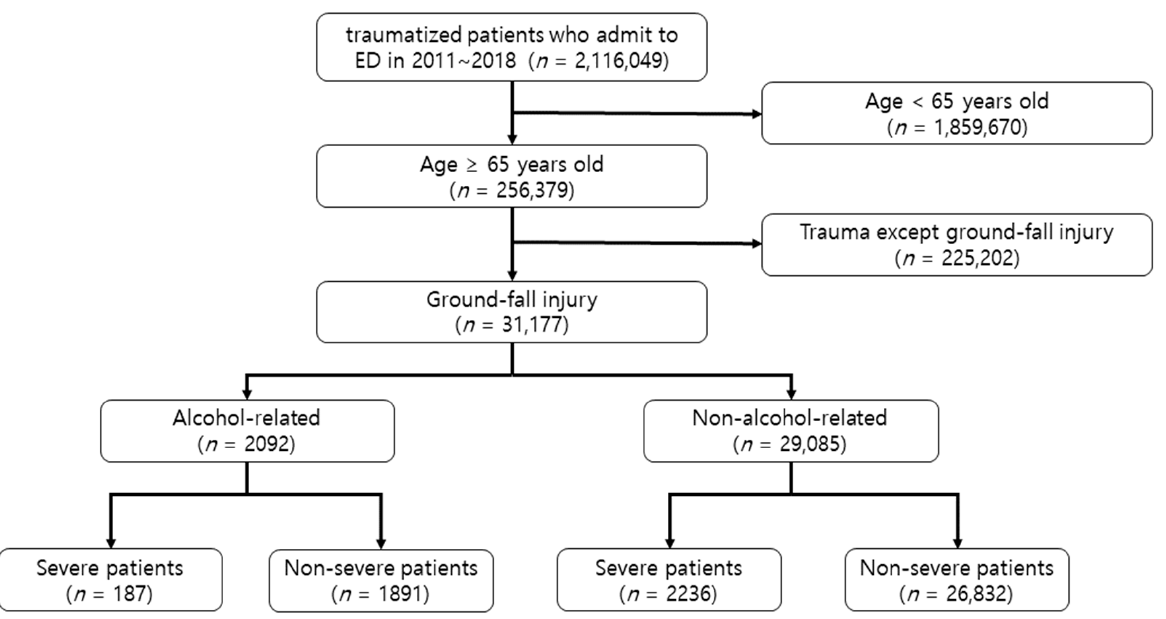
Figure 1. Flow chart of the study population. ED, Emergency room. Table 1. Characteristics of alcohol-related and unrelated ground-fall injuries in the elderly. Alcohol-Related Non-Alcohol-Related (N = 2092) (N = 29,085) General